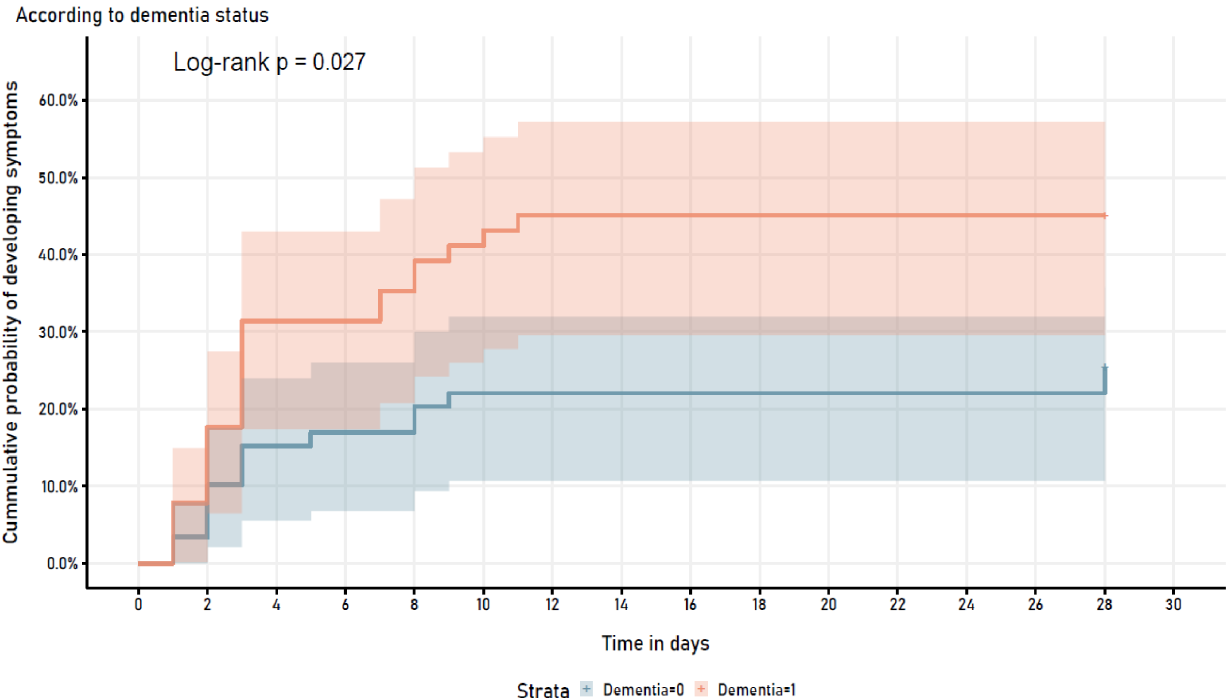
Figure 2. Symptom development in patients who were asymptomatic at time of COVID-19 diagnosis.